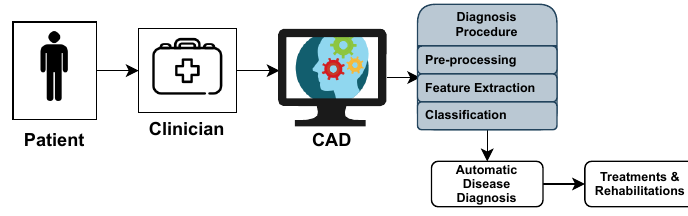
Figure 1. Computer-aided diagnosis (CAD) system